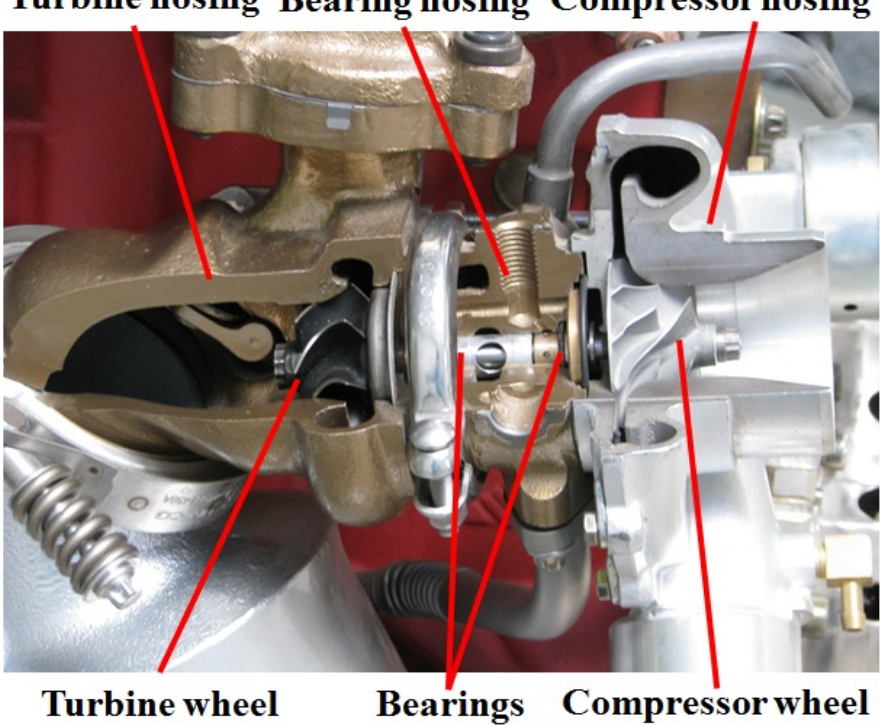
Figure 1. Turbocharger internal parts.